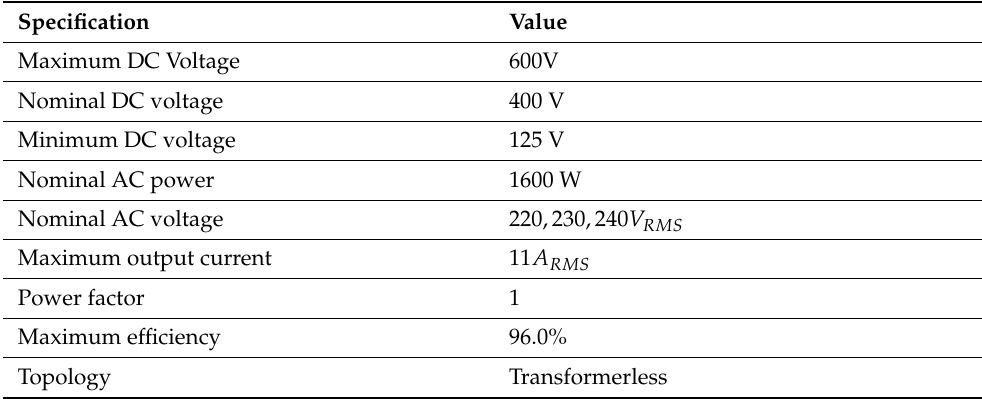
Table 7. Specifications for the Sunny Boy 1600TL